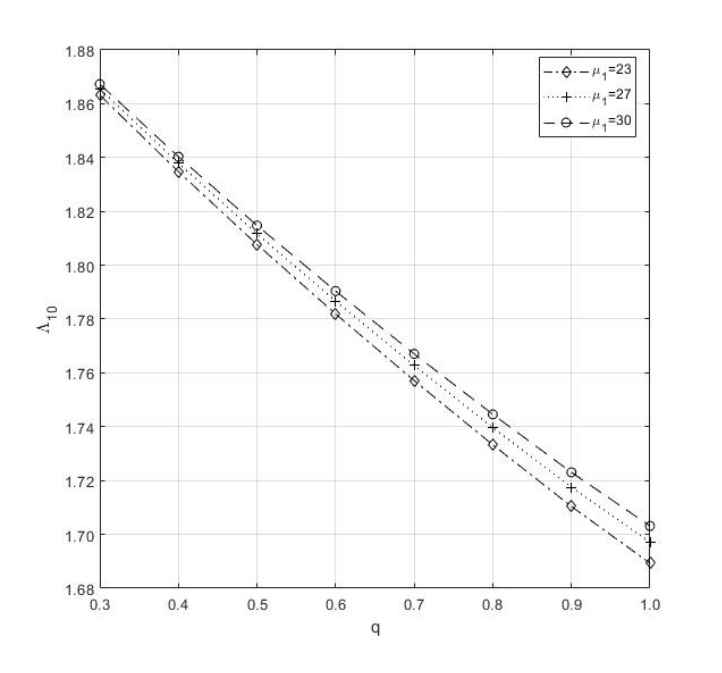
Figure 10. Mean number of Type-I Idle server of µ 1 vs. q .